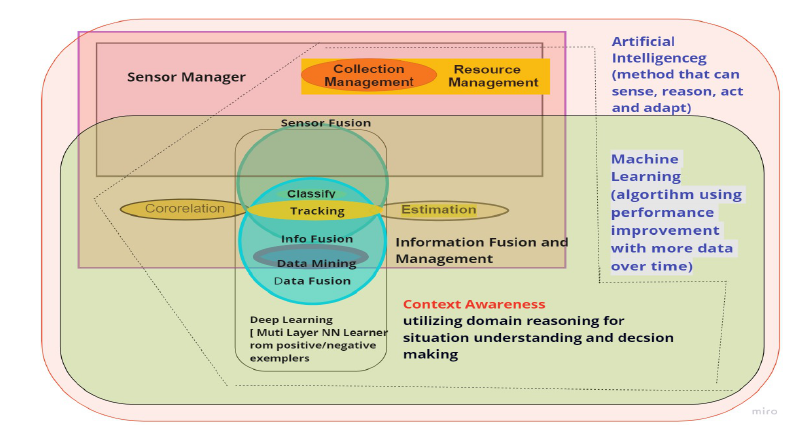
Figure 7. Influence of AI/ML models on data